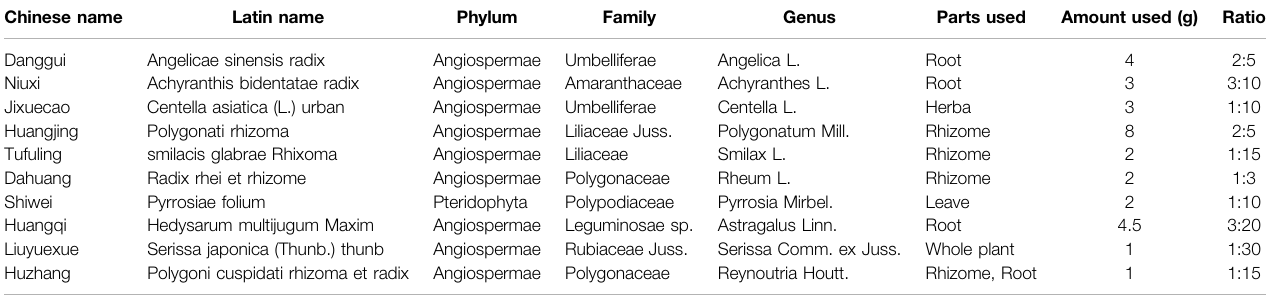
TABLE 1 | Details of YQHG.